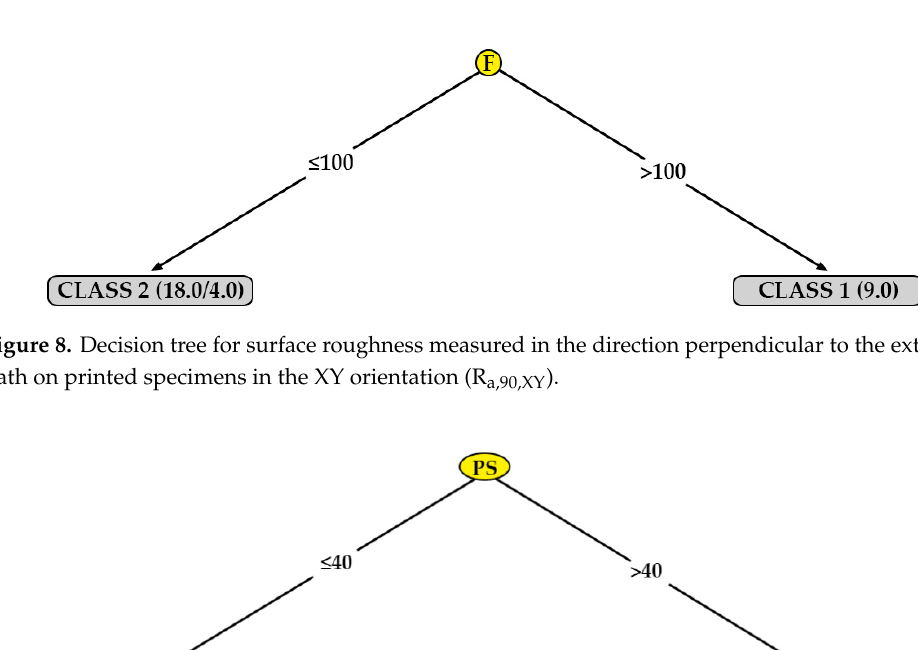
Figure 10. Decision tree for surface roughness measured in the direction perpendicular to the extrusion path on printed specimens in the XZ orientation (R a,90,XZ ). Table 9. Information regarding decision tree models generated in this work.